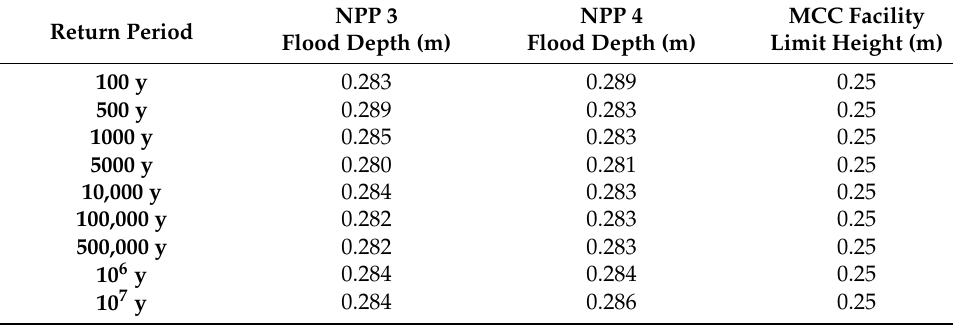
Table 16. Mode flood depths for the control building MCC area (elevation 80